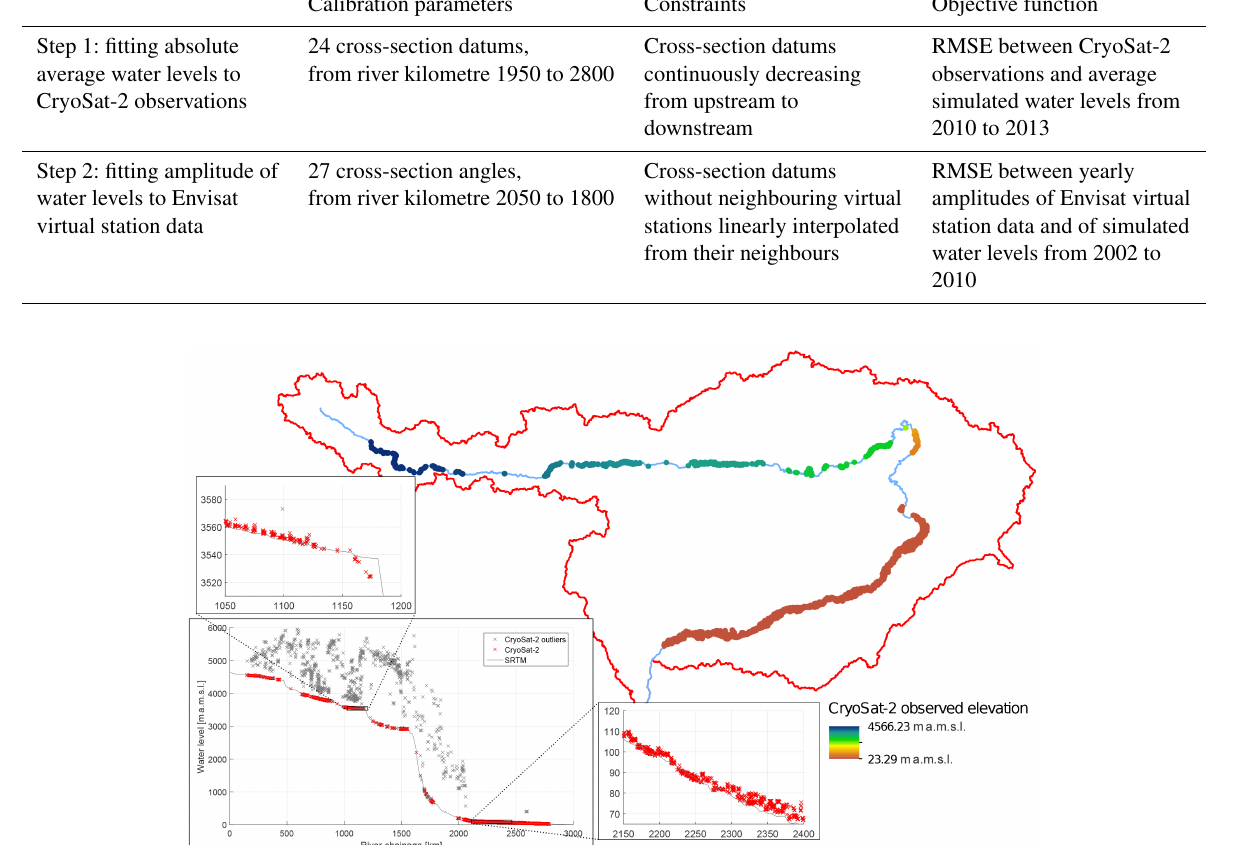
Figure 5. CryoSat-2 observations along the Brahmaputra River from 2010 to 2013. The map only displays the outlier-filtered observations, the longitudinal profiles show both outliers and the outlier-filtered data.